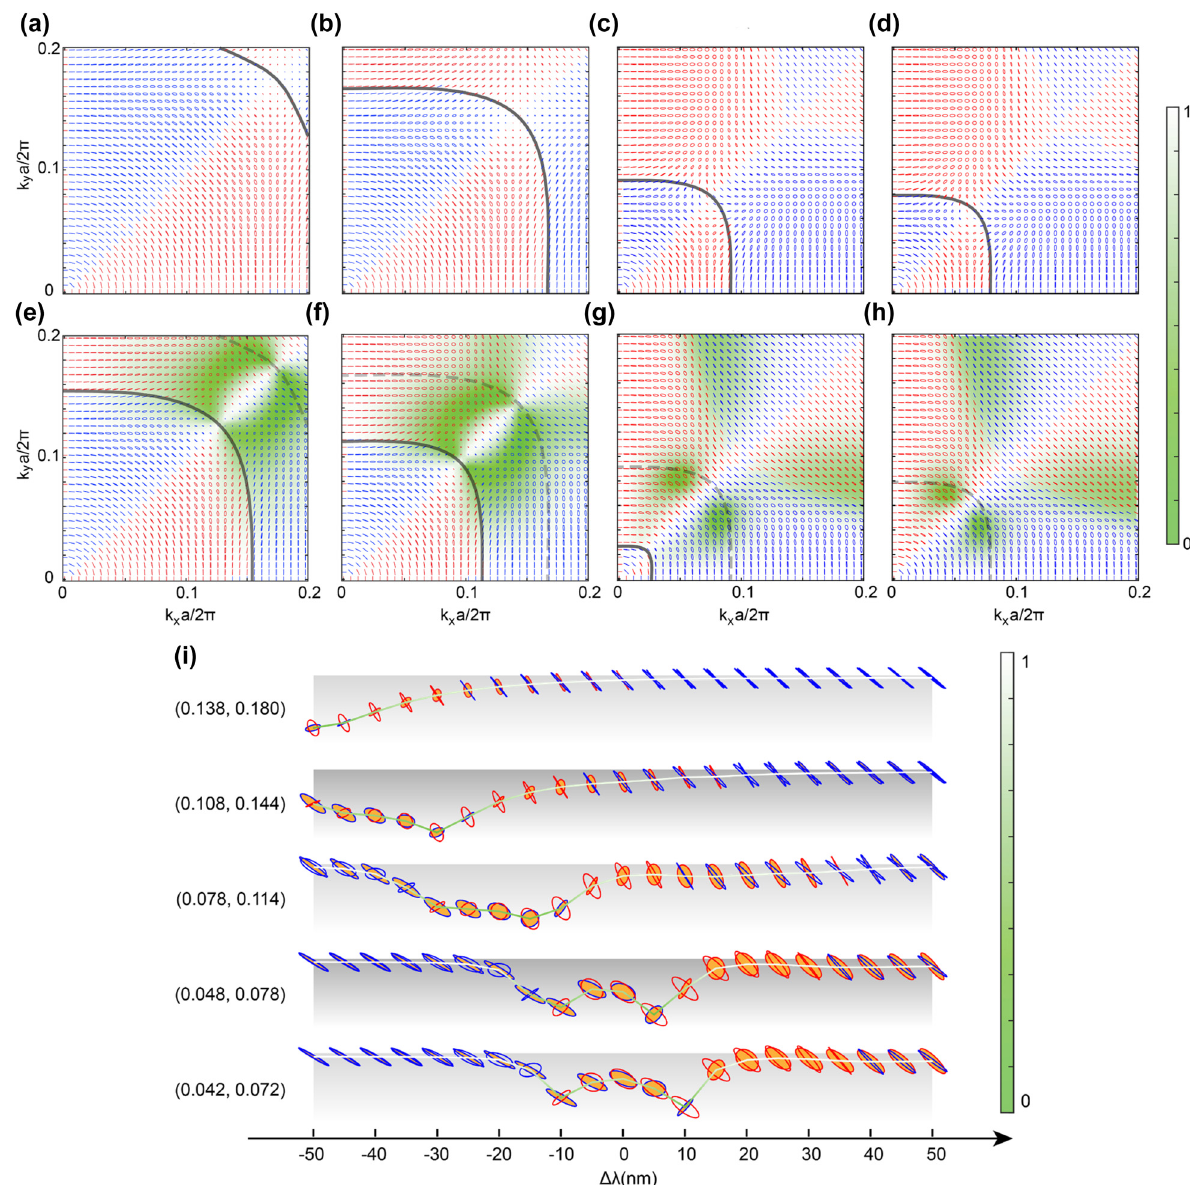
Figure 4: Frequency detuning enabled polarization modulation. (a)–(d) Static polarization ellipses as a function of wavevectors of the s -pol incident light at 𝜆 = 1150 nm, 1170 nm, 1205 nm, and 1210 nm. (e)–(h) Same as panels (a)–(d) but for an optical excitation of fluence of 1.31 mJ/cm 2 ( 𝛥 Re( 𝜀 ) = − 0.362). The color-coded background represents the correlation factor between the polarization states at static and optically excited states at the corresponding wavelengths. (i) The correlation factor at selected wavevectors as a function of the wavelength. The corresponding polarization ellipses at the static state (orange-filled) and the excited state (open) are also presented, where the red (blue) color of the ellipses represents the right